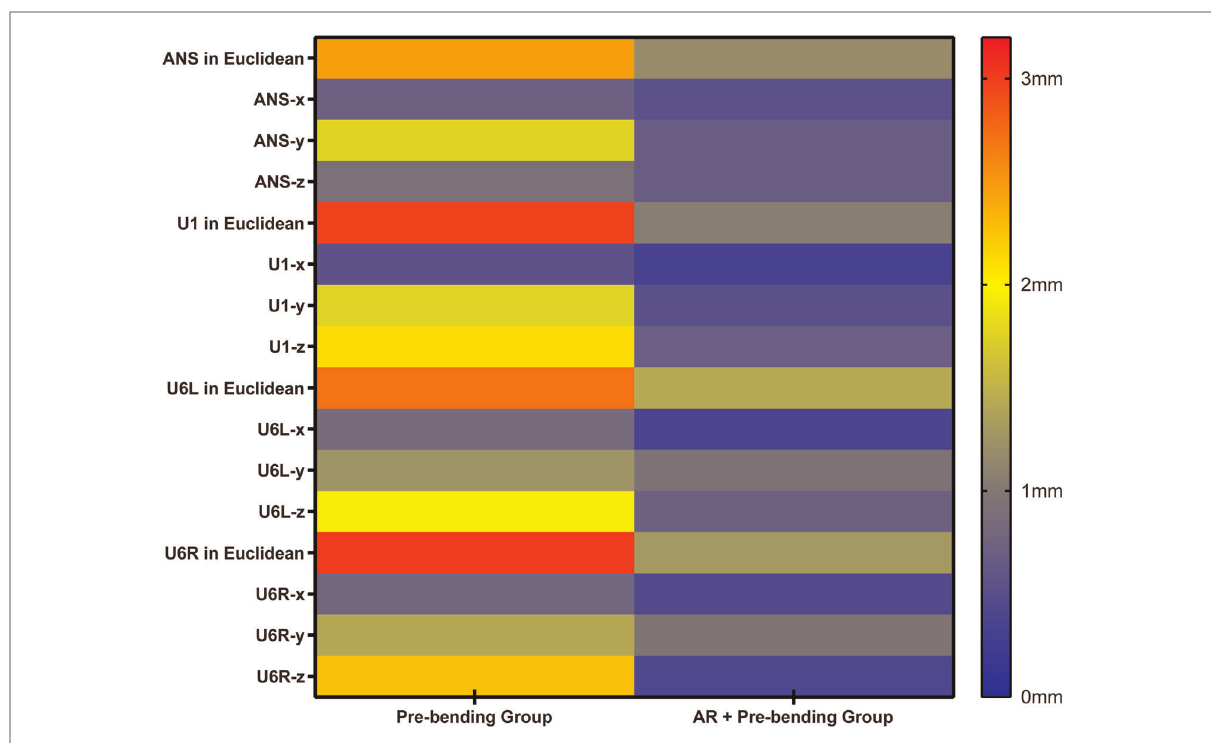
FIGURE 6 Differences between the two groups in linear deviations of the distraction result note: ANS in Euclidean, ANS-x, ANS-y, and ANS-z, respectively, represented the linear deviation in Euclidean distance, x, y, and z-axes of landmark ANS. U1 in Euclidean, U1-x, U1-y, and U1-z, respectively, represented the linear deviation in Euclidean distance, x, y, and z-axes of landmark U1. U6l in Euclidean, U6l-x, U6l-y, and U6l-z, respectively, represented the linear deviation in Euclidean distance, x, y, and z-axes of landmark U6l. U6R in Euclidean, U6R-x, U6R-y, and U6R-z, respectively, represented the linear deviation in Euclidean distance, x, y, and z-axes of landmark U6R. The vertical gradient color strip located on the right side of the fi gure shows the color represented in distance error levels, from 0 mm (blue) to 3.2 mm (red), and the baseline is 2 mm (yellow), which represents clinically acceptable error.